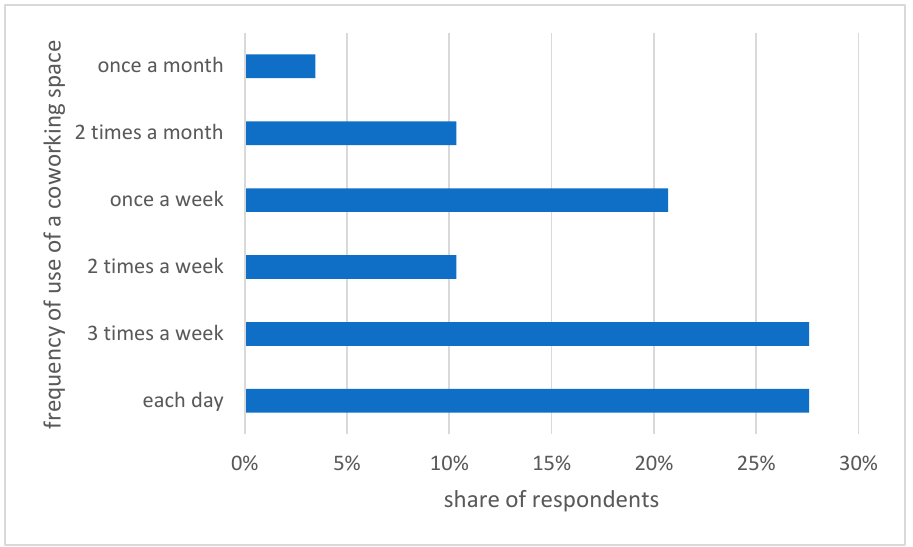
Figure 2. Frequency of use per week or month.